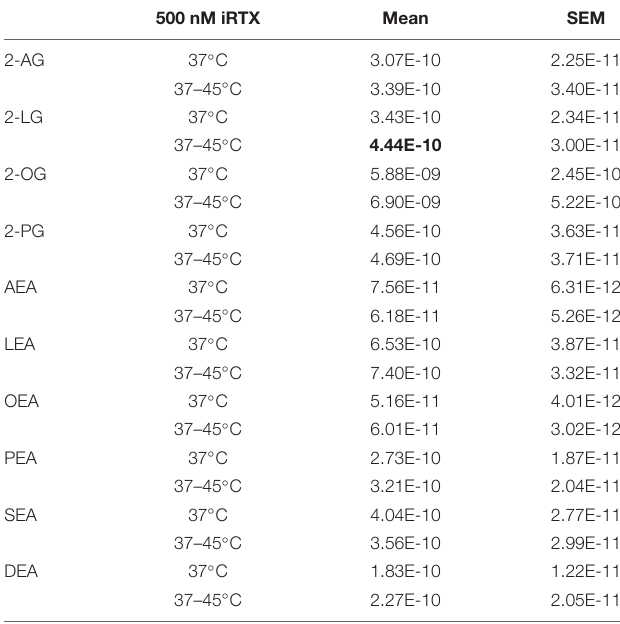
TABLE 1 | Levels of lipids in HEK-TRPV1 cells after heat ramp from 37–45 ◦ C in the presence of the TRPV1 antagonist,